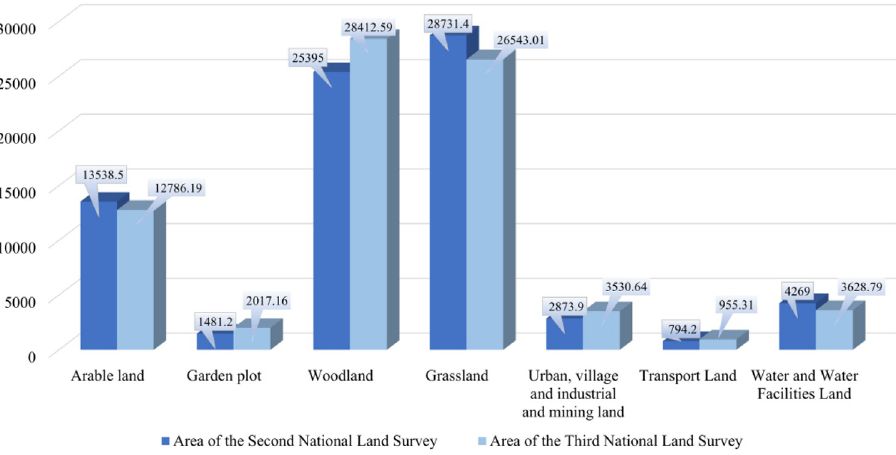
Fig 4. China’s second and third national land surveys (unit: million hectares).